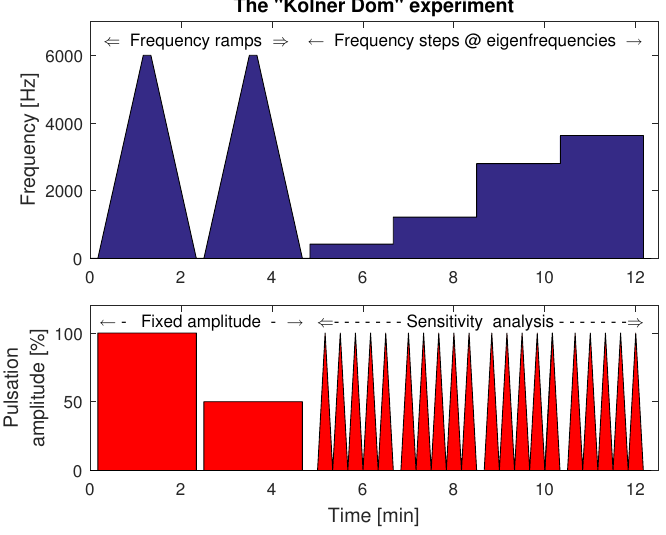
Figure 14. The “Kölner Dom“ experiment, or the typical sequence of excitation of the siren for an acoustic characterisation of the